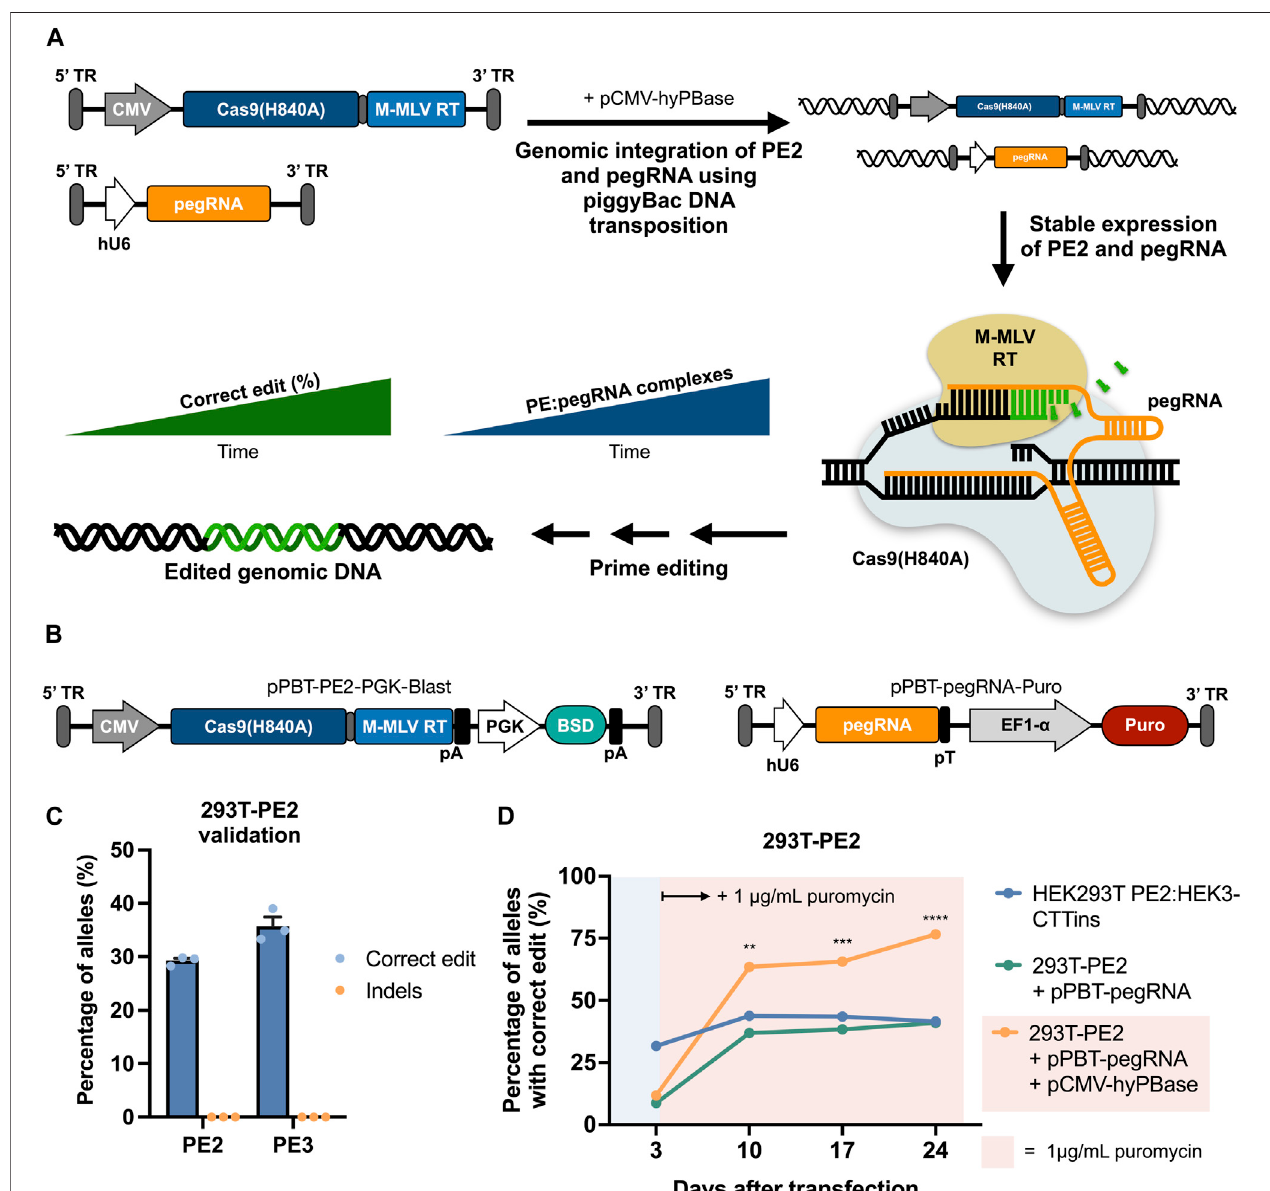
FIGURE 1 | | Prime editing by piggyBac-mediated transposition of PE2 and pegRNA cassettes using separate piggyBac vectors. (A) Graphical overview of prime editing based on piggyBac DNA transposition, demonstrating the concept of potent editing as a result of stable expression of both PE2 and pegRNA. (B) Schematic representation of the piggyBac vectors carrying either PE2 (left) or a pegRNA (right). (C) Integration of the Cas9-RT expression cassette alone into HEK293T cells facilitates correct editing at the HEK3 target when transfected with a HEK3-CTTins pegRNA (PE2) as well as when transfected with an additional nicking sgRNA (PE3).Editingratesweredetermined3 daysaftertransfection. (D) IntegrationoftheHEK3-CTTinspegRNAexpressioncassetteinto293T-PE2cells(293T-PE2+pPBT- pegRNA+pCMV-hyPBase)resultsinincreasedprimeeditingovertimecomparedtocellswithtransientlyexpressedPE2andpegRNA(HEK293TPE2:HEK3-CTTins)or transiently expressed pPBT-pegRNA-Puro (293T-PE2 + pPBT-pegRNA). Puromycin was applied at day 3 after transfection only to cells with stably integrated pegRNA cassette. Data and error bars show mean ( n (cid:2) 3) ± sd. Statistical signi fi cance was calculated using multiple unpaired t -tests with correction for multiple testing (** p < 0.002, *** p < 0.0002, **** p < 0.0001).